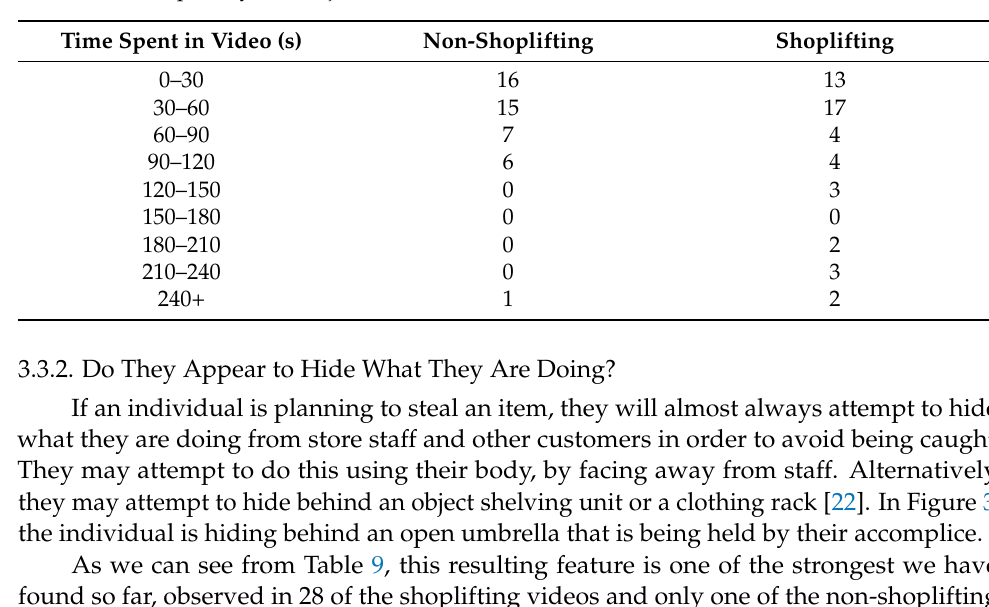
Table 8. Times spent by the subject in the video in seconds.